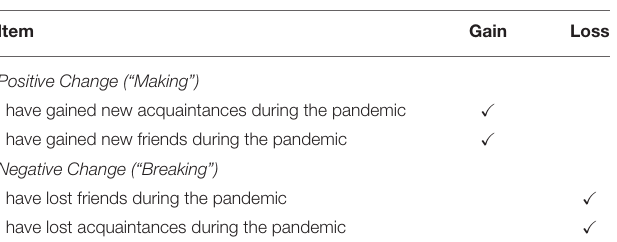
TABLE 1 | Types of network